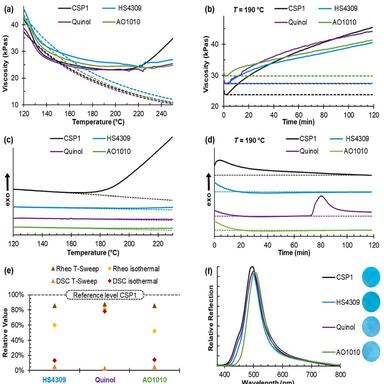
Analysis of the temperature stability of CSP with different antioxidative stabilizers. CSP1 represents the original batch, without additives. (a) Temperaturedependent rheological examinations in ambient atmosphere in terms of dynamic complex viscosities. In a temperature range from 35 ◦C to 165 ◦C measured viscosities were fitted to Arrhenius-Law and extrapolated for temperatures > 165 ◦C. (b) Isothermal rheological examinations in ambient atmosphere. The minimum viscosity after a homogenous sample temperat